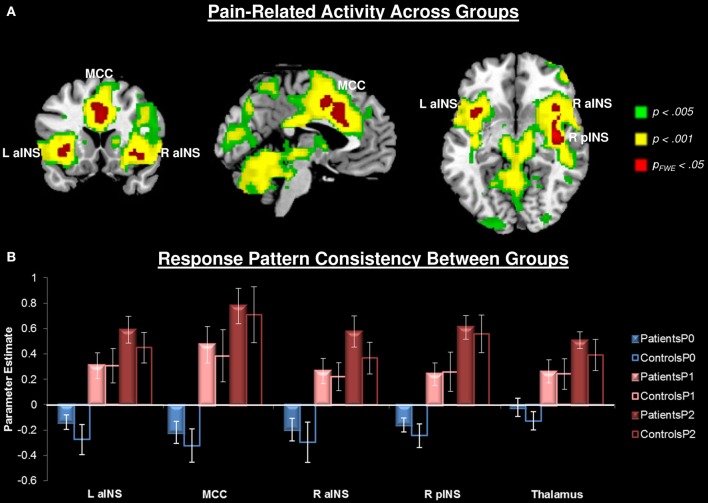
Pain-related neural responses among all participants (n = 28). Pain was evoked with a contact heat thermode applied to the participants' left volar forearm. (A) Whole brain contrast [Pain (P1+P2) > No Pain (P0)], at the a priori defined threshold puncorrected < 0.005 (green), a more stringent threshold of puncorrected < 0.001 (yellow), and the most conservative pfwe < 0.05 (red). For subsequent analyses, activity was extracted from the most conservative threshold (red clusters) to isolate separable clusters. Right thalamus also activated at this threshold, but is not seen at these slices. (B) Extracted activity from significant (pfwe < 0.05) clusters: left anterior insula (L aINS), midcingulate cortex (MCC), right anterior insula (R aINS), right posterior insula (R pINS), and thalamus demonstrates that response pattern was consistent across groups. No pain (P0), mild pain (P1), moderate pain (P2).